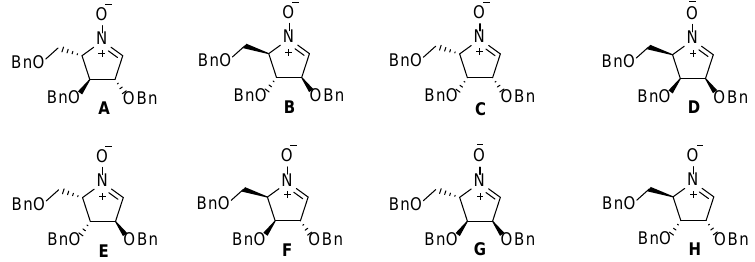
Figure 3. Polyhydroxylated nitrones used in building pyrrolidine cores.